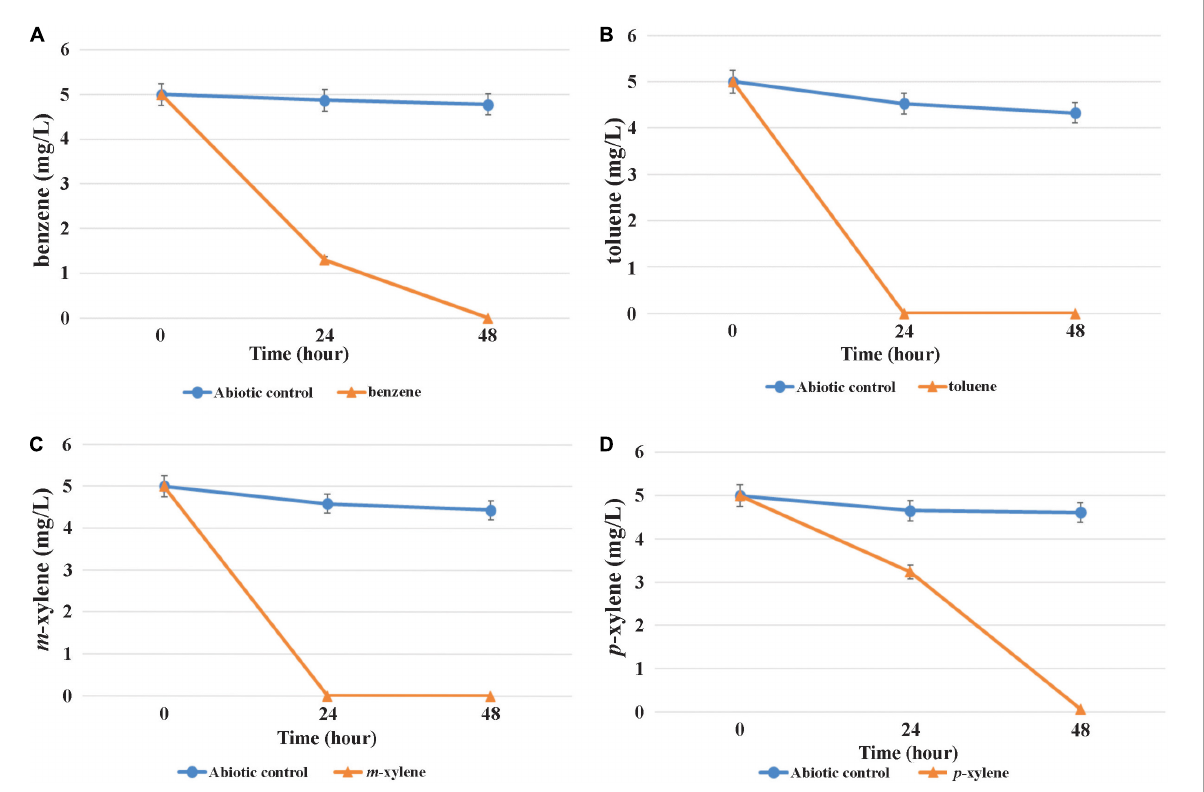
FIGURE6 Microaerobic degradation of BTEX compounds [ (A) : benzene, (B) : toluene, (C) : m -xylene, (D) : p -xylene] by strain MAP12 T . Concentrations were determined by GC–MS analysis as described in the main text. The averages of triplicate experiments ± standard errors of the means, indicated by error bars, are